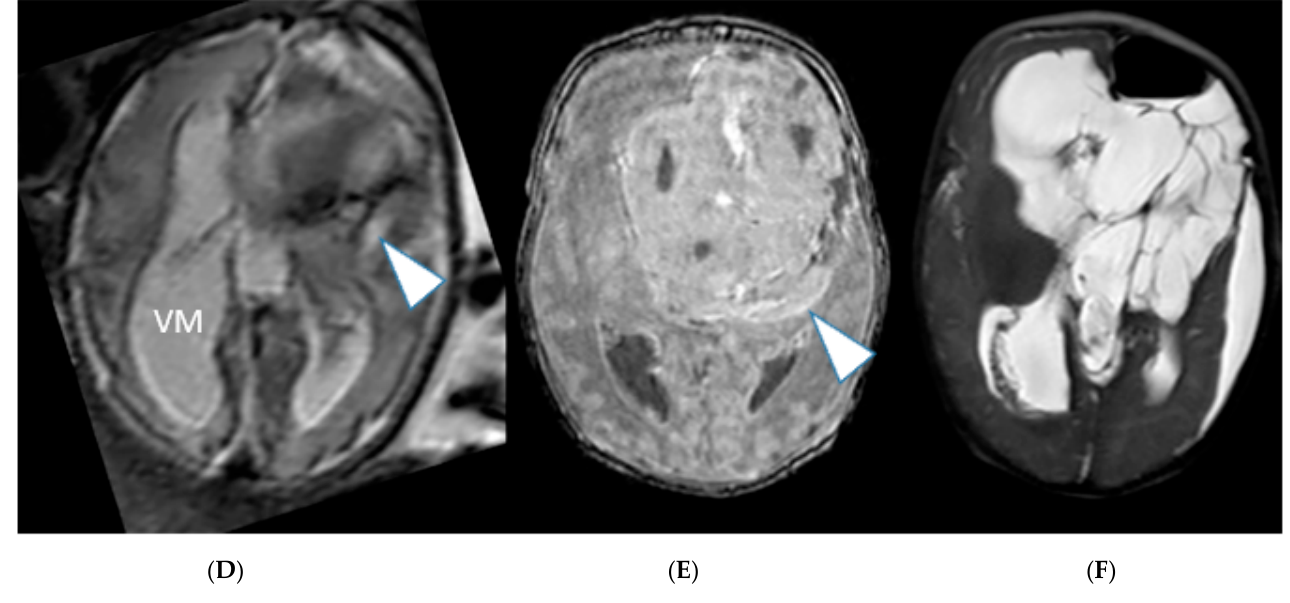
Figure 7. ( A – C ) Prenatal gray scale and color-coded Doppler US ( A – C ) and axial T2-weighted fetal MRI ( D ), postnatal contrast enhanced T1-weighted and postoperative follow up T2-weighted MRI show a large lobulated solid mass lesion in the left frontal lobe (arrowhead). Post-surgery the tumor has become T2 ‐ hyperintense cystic. Ventriculomegaly (VM) is secondary to compression of the foramina Monro ( E , F ).